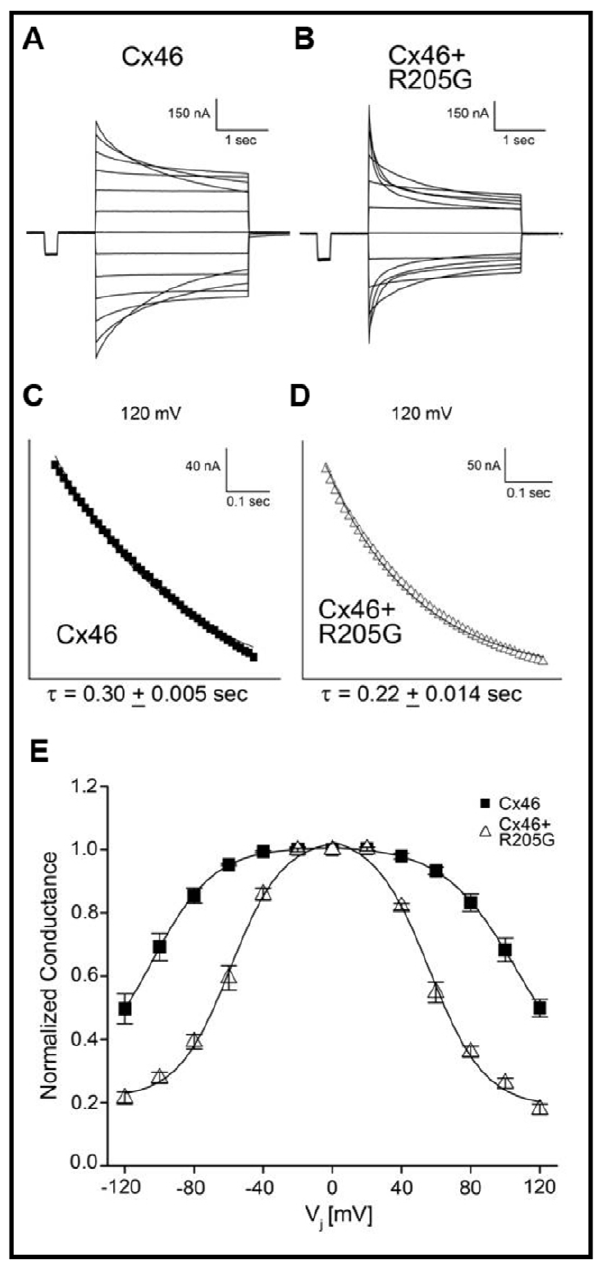
Figure 6. Voltage-gating properties of Cx46 and mixed Cx46/ Cx50-R205G channels. The decay in junctional current (I j ) induced by transjunctional voltage (V j ) was plotted as a function of time for gap junctions comprised of Cx46 ( A ) and mixed Cx46/Cx50-R205G ( B ). Voltage was stepped to 6 120 mV in 20 mV increments. At all voltage applications . 6 20 mV, mixed channels showed a more rapid current decay toward steady state. Analysis of channel closure kinetics was based on representative traces displaying the initial 250 ms of current decay recorded after application of a + 120 mV transjunctional voltage, for gap junctions comprised of homomeric wild-type Cx46 (n=5) ( C ) and heteromeric channels containing both Cx46 and Cx50-R205G (n=5) ( D ). Current traces were fit to monoexponential decay to determine the mean time constant, t . Heteromeric Cx46 and Cx50-R205G channels closed , 25% faster than homomeric Cx46 channels, displaying